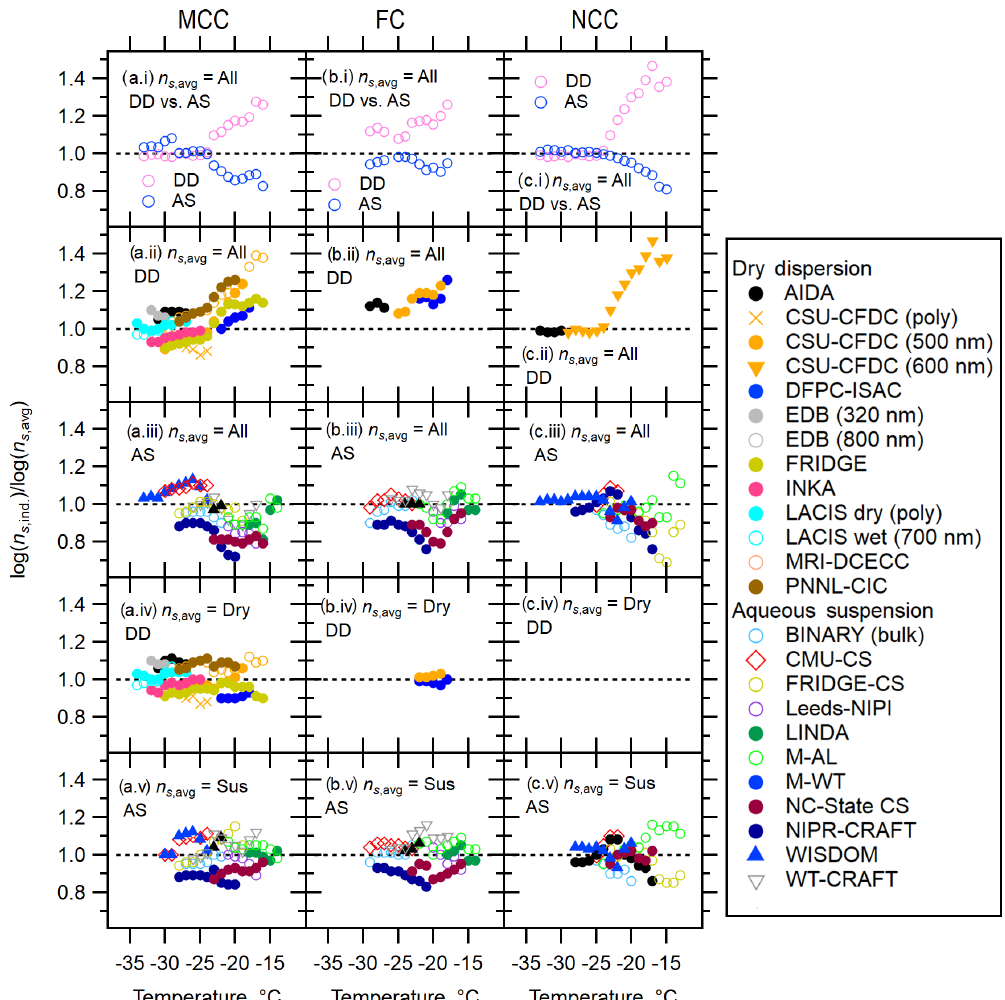
Figure 2. T -binned ratios of the interpolated individual measurements to the average of the data, log( n s , ind . )/ log (n s , avg ) , based on the geometric surface area ( n s , geo ) for MCC (a) , FC (b) and NCC (c) . T -binned log( n s , ind . )/ log (n s , avg ) values are presented for (a.i–c.i) ratios of the log average to dry dispersion measurements (DD) or aqueous suspension measurements (AS) to the log average to all the data (All), (a.ii–c.ii) ratios of the individual DD measurements to all, (a.iii–c.iii) ratios of the individual AS measurements to all, (a.iv–c.iv) ratios of the individual particle dispersion measurements to DD and (a.v–c.v) ratios of the individual aqueous suspension measurements to AS. The black dotted line represents log( n s , ind . )/ log (n s , avg ) = 1. (c.iv) is left blank since only one dataset is available at each temperature; thereby, no differences can